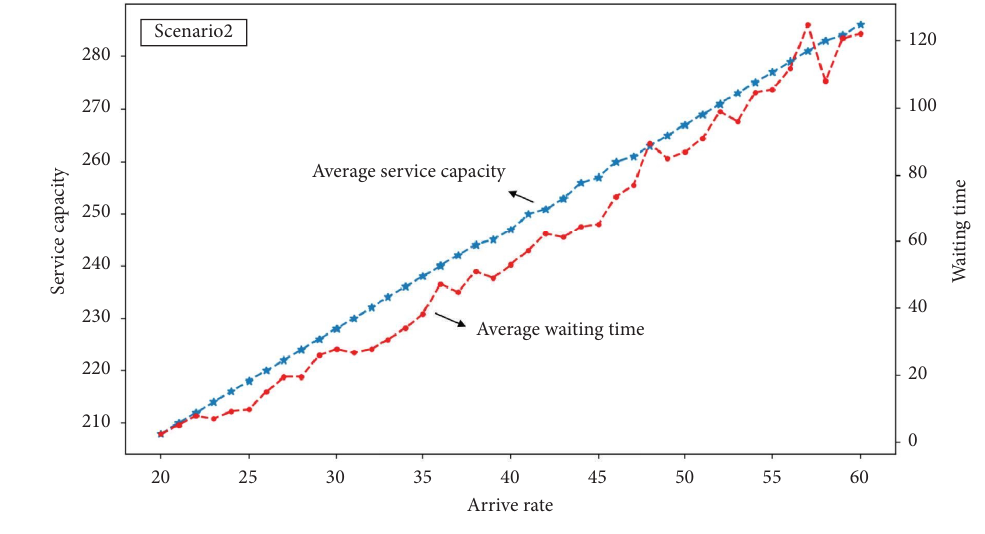
Figure 26: Simulation results of scenario 2. Table 10: Results in diferent